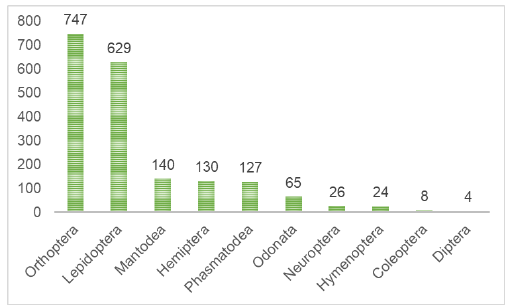
Figure 8. Number distribution of each order in our